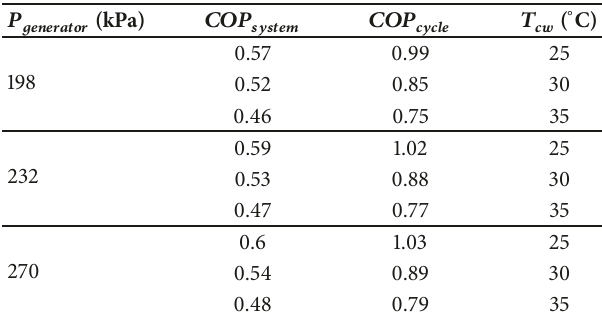
Table 6: Maximum 𝐶𝑂𝑃 reached for solution generator tempera- ture set at 210 ∘ C (maximum considered) and 𝑇 𝑐 = 7 ∘